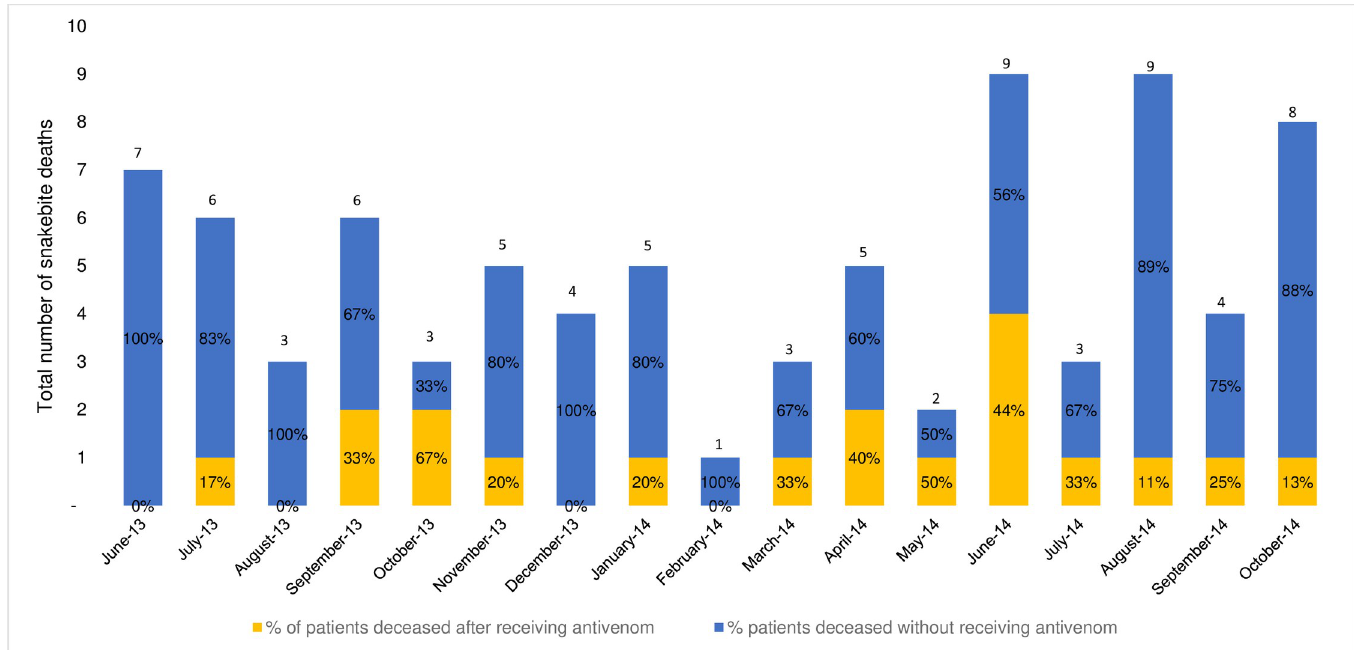
Fig 4. Number of hospitalised snakebite patient deaths and percentage deaths in patients who did, and did not receive antivenom treatment.